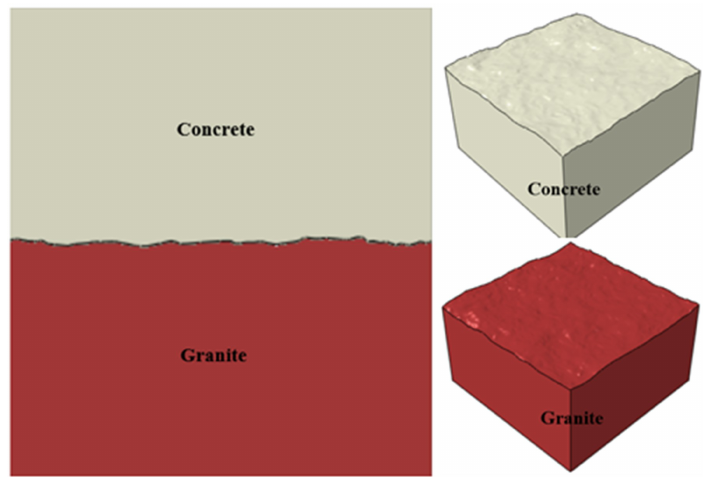
Figure 16. Concrete–granite